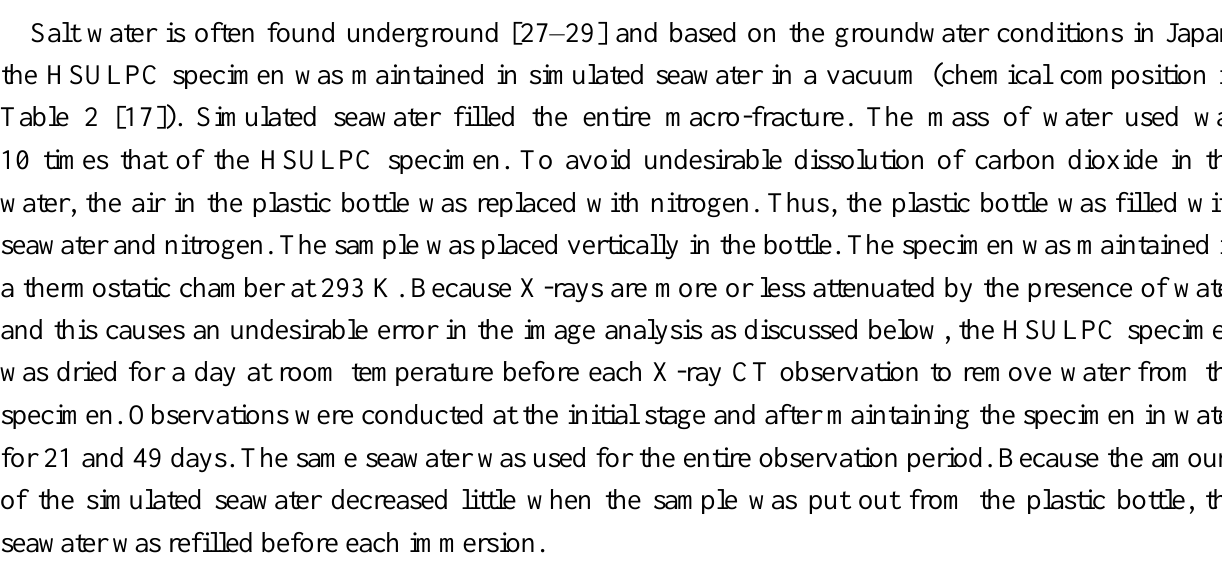
Table 2. Chemical composition of simulated seawater (mol L −1 ) (Adapted from Fukuda et al. [17]). Ca 2+ SO 32− Na + K + Cl − Mg 2+ HCO 3− 10 × 10 −3 29 × 10 −3 45 × 10 −2 19 × 10 −3 56 × 10 −2 55 × 10 −3 24 × 10